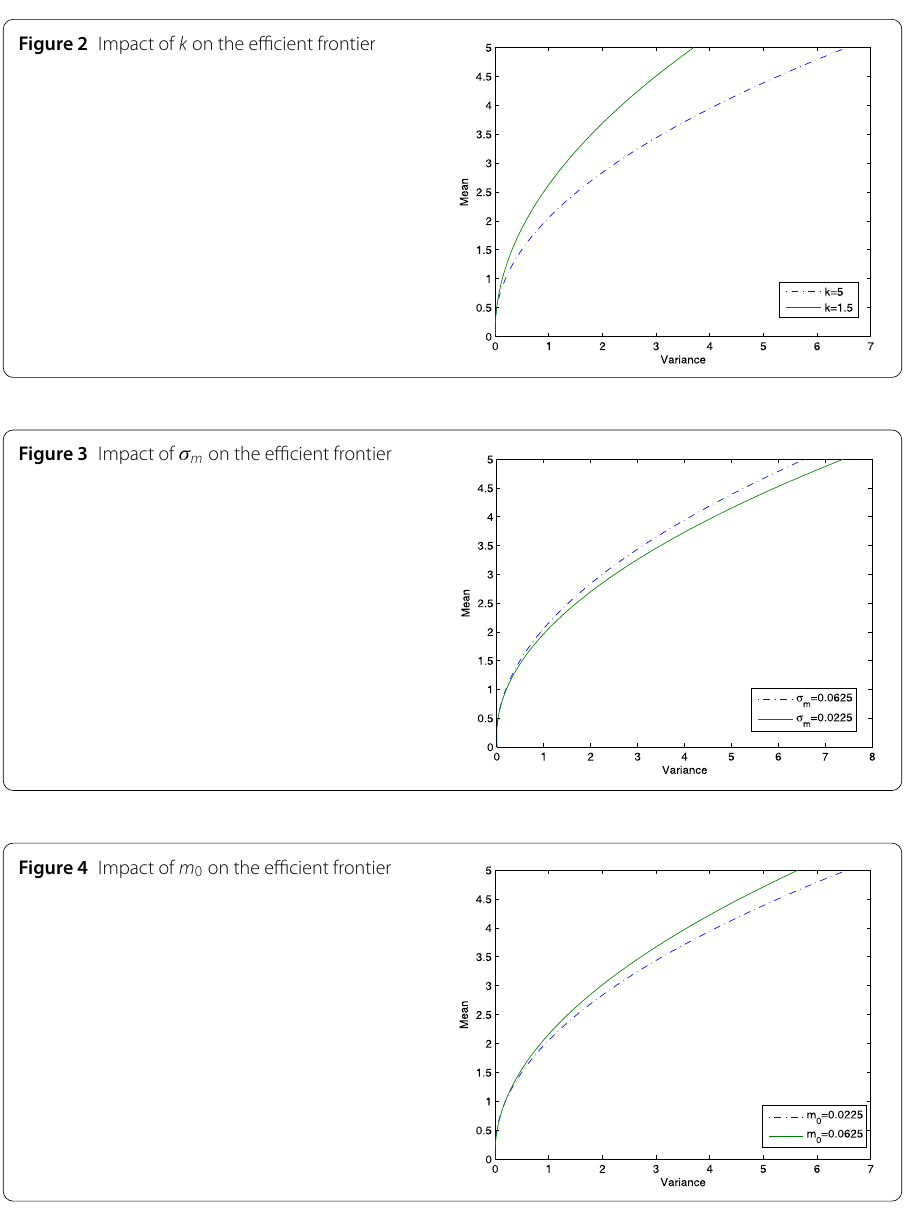
Figure 2 Impact of k on the efficient frontier